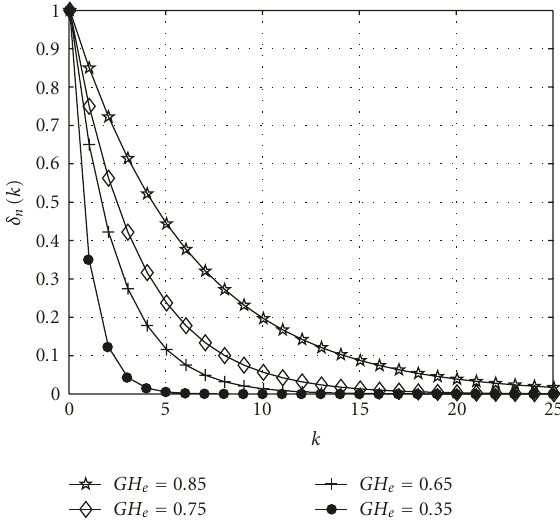
Figure 3: Relative image-dependent error δ r ( k ). Figure 4: Relative noise-dependent error δ n ( k